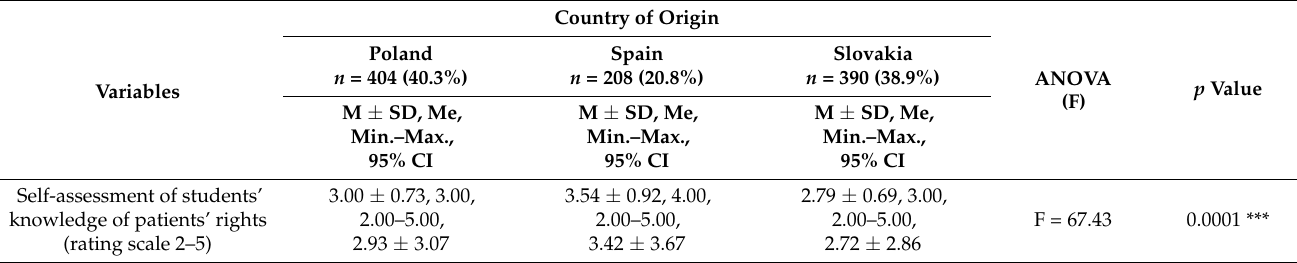
Table 2. Variation in students’ self-assessed knowledge of patients’